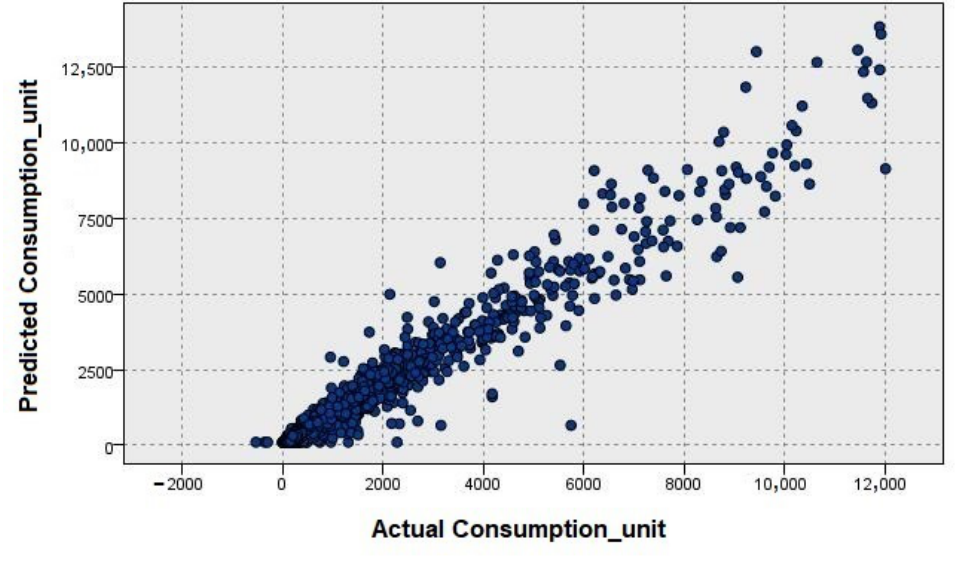
Figure 13. Scatter plots showing the relationship between the actual and predicted power consump- tion values using the ANN.